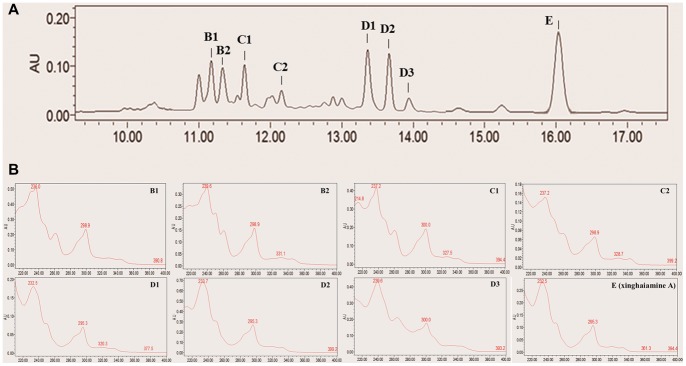
Production of a family of compounds with unique UV spectra by S. xinghaiensis. 1a, HPLC profile of fermentation crude extract produced by S. xinghaiensis. The elution was monitored at 254 nm at a flow rate of 0.85 ml/min. 1b, UV absorption of the compound family. Compound E was named as xinghaiamine A.